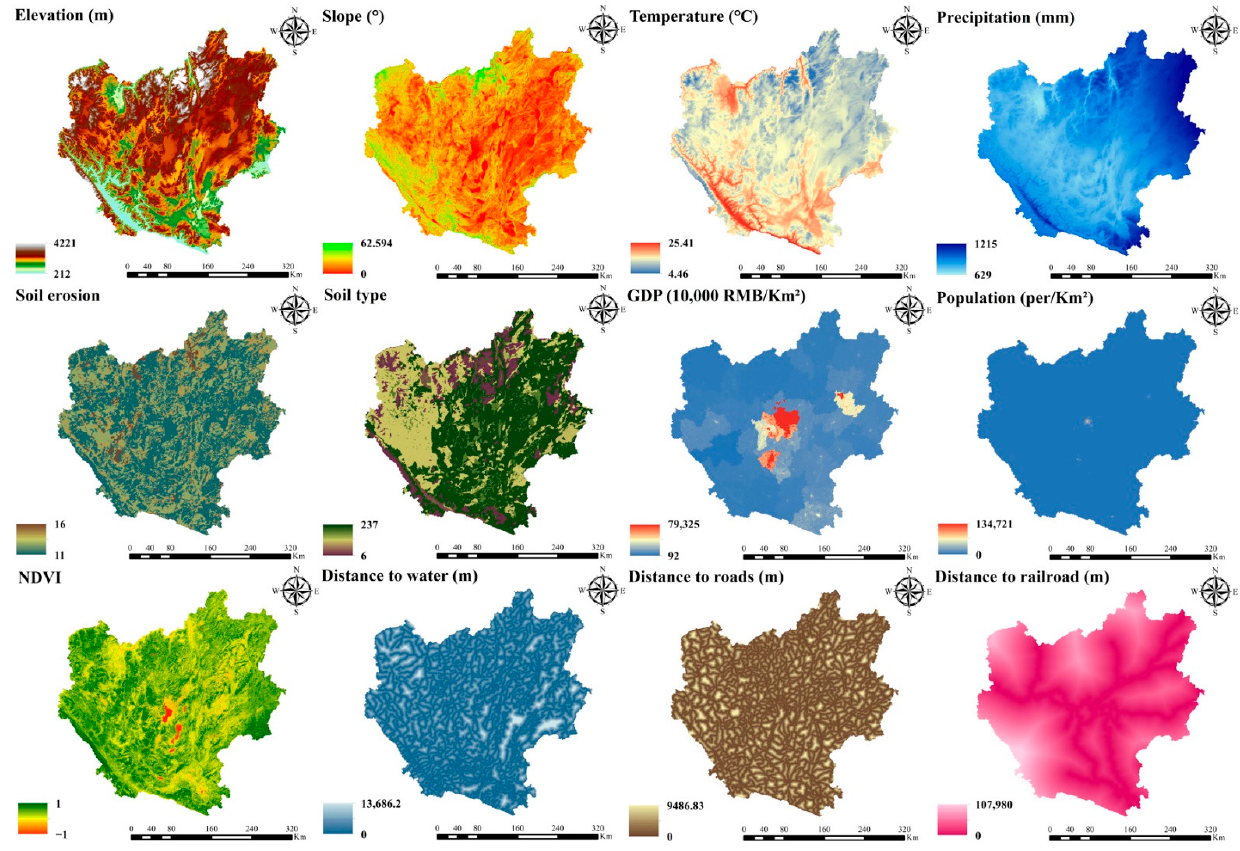
Figure 2. Land driving